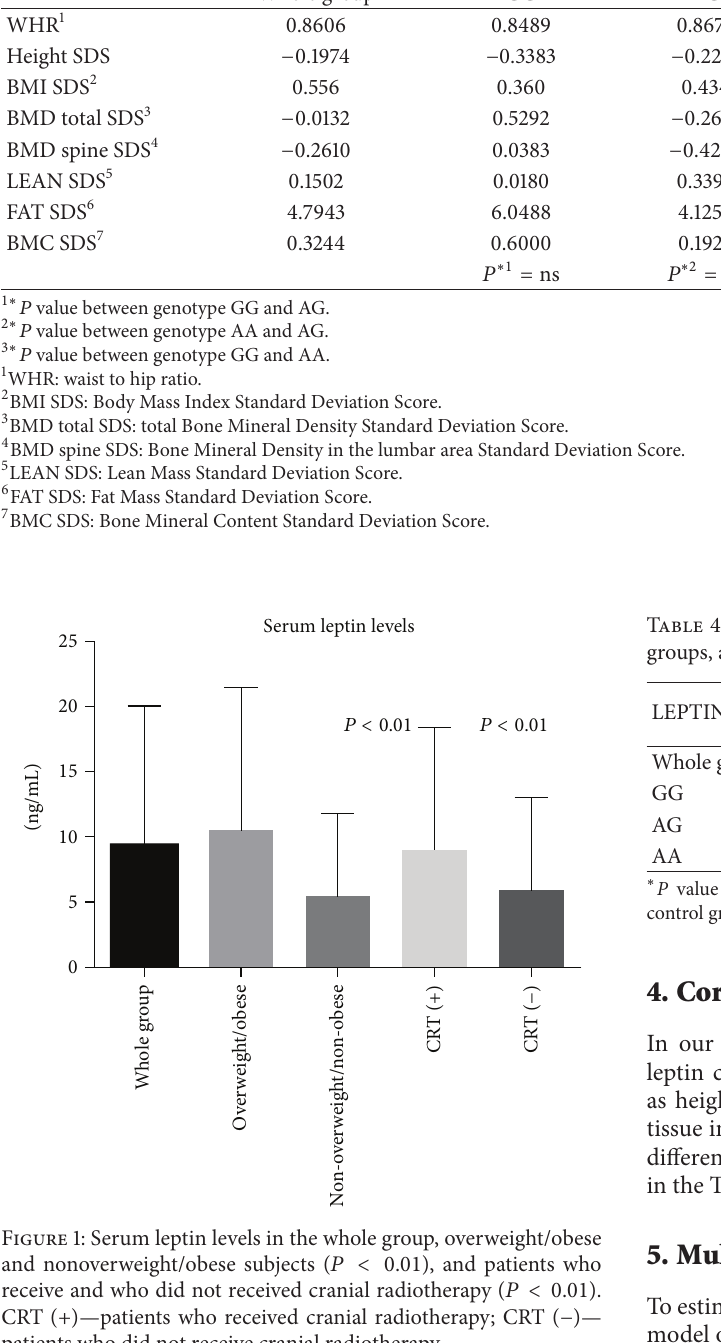
Table 3: Values of the anthropometric and densitometric parameters in the whole group, according to Q223R LEPR genotype. Whole group GG AG AA F P